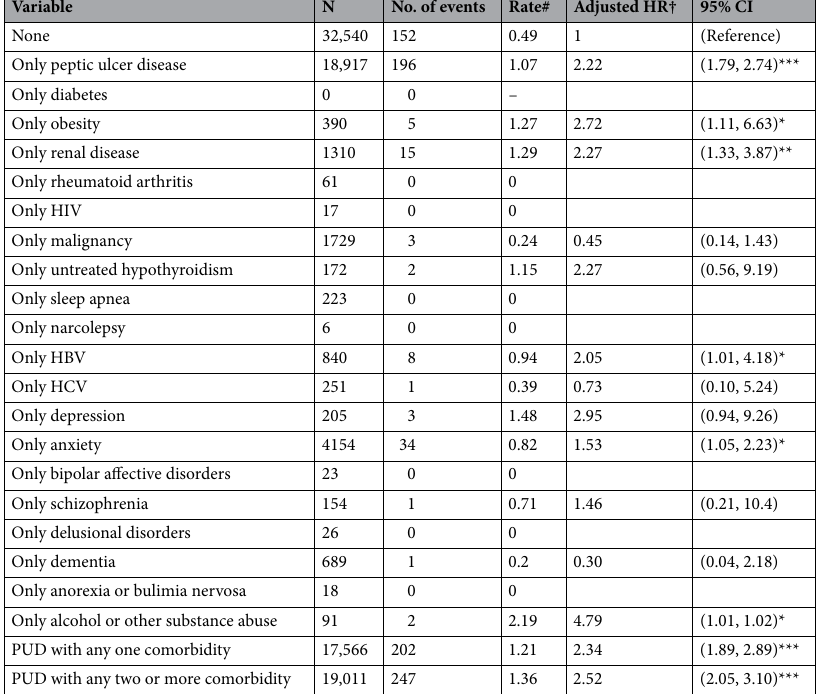
Table 3. Joint effects for chronic fatigue syndrome between peptic ulcer disease and chronic fatigue syndrome -associated risk factors. Rate# incidence rate. No., Number; 95% CI 95%, confidence interval; HIV, human immunodeficiency virus; PUD, peptic ulcer disease. Adjusted HR†: multivariable analysis including age, and sex. *p < 0.05, **p < 0.01, ***p < 0.001.